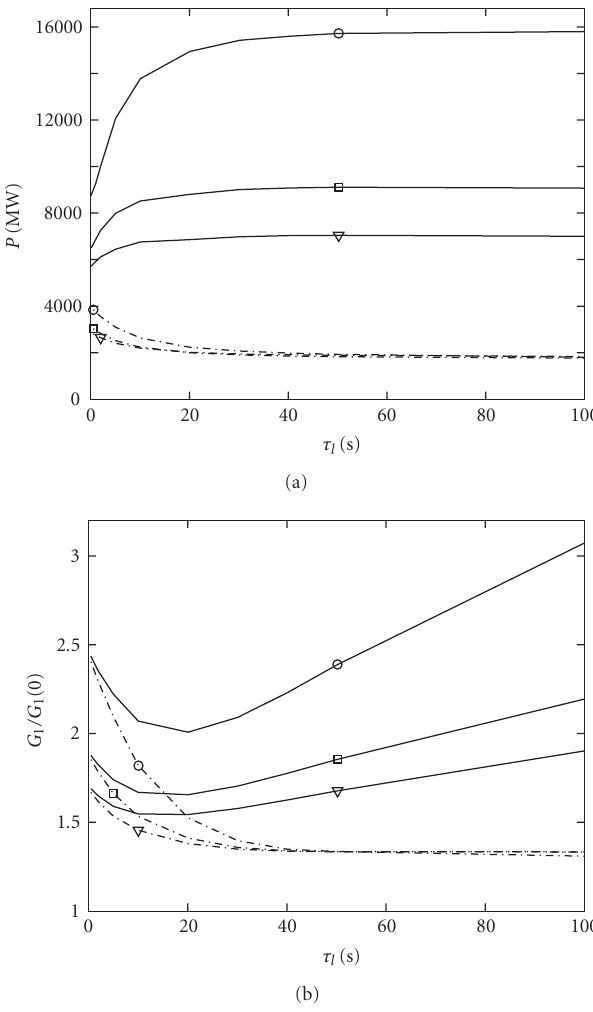
Figure 9: Characteristics of the stable power and precursor oscil- lation in the presence of feedback as a function of the recirculation time τ l . The solid line represents the maximum value during the os- cillation, the dash-dotted line the minimum. Di ff erent values of the feedback coe ffi cient are considered: α = 1 . 53 pcm/ ◦ C ( ◦ ), α = 3 . 06 pcm/ ◦ C ( (cid:2) ), α = 4 . 59 pcm/ ◦ C ( ∇